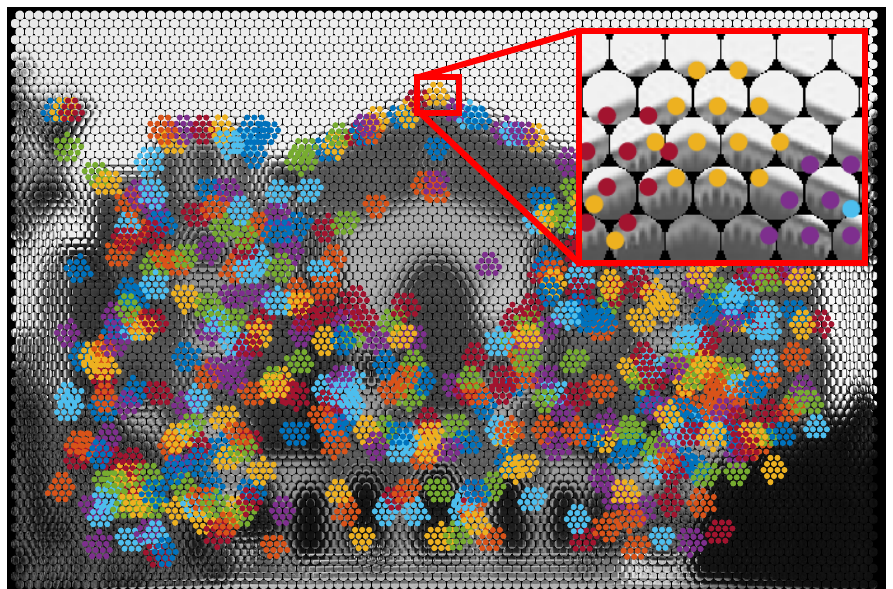
Figure 9. Example of detected results on simulated raw image using proposed algorithm based on 2-layer CPSFS with R gt = − 4, ∆ R = 2. Note that different colors in figure are used to distinguish the features projected by diverse plenoptic disc